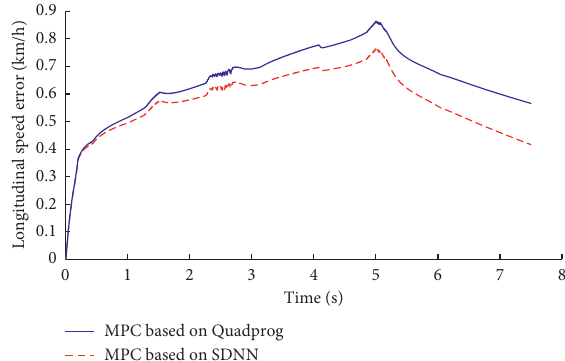
Figure 29: Longitudinal speed errors of the LV and the FV of two